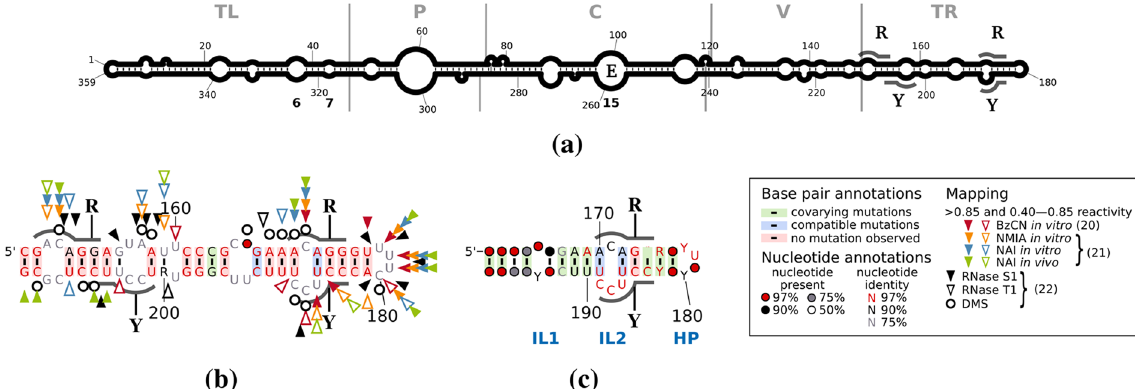
Figure 1. Secondary structure of pospiviroids. The consensus sequence and structure presented were predicted for alignments with MAFFT 66 , optimized in ConStruct 67 at 37 °C, excluding lonely base pairs, and drawn with R2R 68 . ( a ) Structure of circular PSTVd. Borders of the five domains 74 (TL, terminal left; P, pathogenicity-related; C, central; V, variable; TR, terminal right) are marked by gray lines. Loops 6, 7, and 15 (E) are marked. RY motifs critical for binding of Virp1 12 are outlined and marked by R and Y. ( b ) TR domain based on an alignment of 234 full-length unique PSTVd sequences. High and low SHAPE reactivity is marked by filled and open triangles, respectively [red 62 ; orange, blue and green 75 ]; reactivity with RNase S1 (black triangle), RNase T1 (open triangle), and dimethyl sulfate (DMS, circle) is marked 76 . ( c ) Terminal right stem-loop based on an alignment (see Supplementary Fig. S2) of unique TR sequences of 95 pospiviroids (14 PSTVd, 25 CEVd, 21 columnea latent viroid (CLVd), 8 chrysanthemum stunt viroid (CSVd), 3 iresine viroid (IrVd), 3 Mexican papita viroid (MPVd), 10 pepper chat fruit viroid (PCFVd), 4 tomato apical stunt viroid (TASVd), 7 tomato chlorotic dwarf viroid (TCDVd)). The internal loops are marked by IL1 and IL2, respectively, and the hairpin loop by HP. The color code used in (b) and (c) for the annotation of nucleotides, base pairs and mapping is given in the right